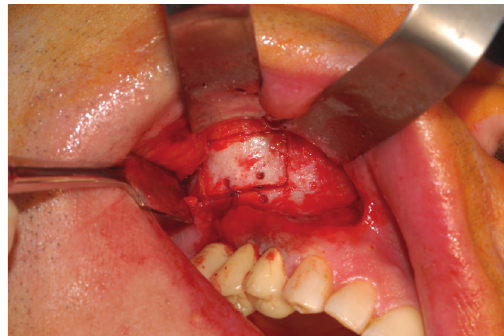
Figure 8: The bony segment is repositioned and secured with absorbable sutures.